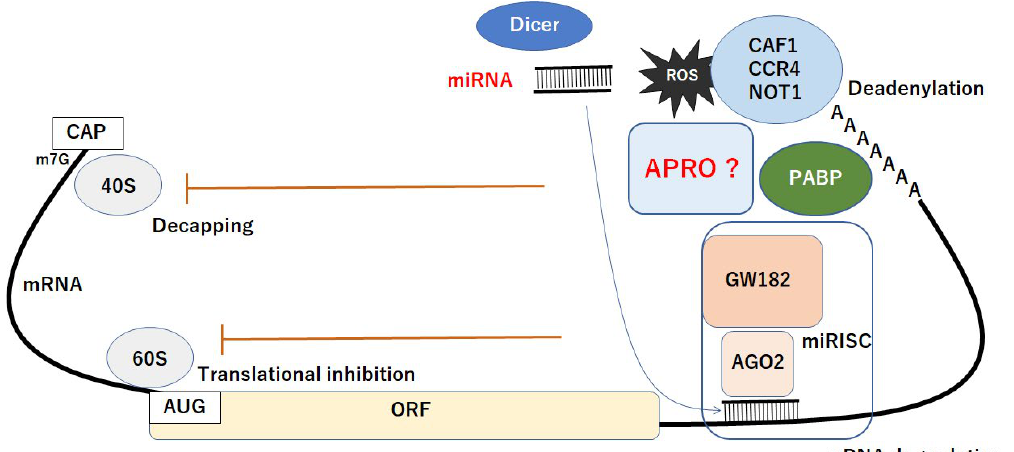
Figure 2. Schematic representation of miRNA-mediated functional inhibition of mRNA. The AGO2 protein interacts with GW182 constructing the miRISC complex, which may facilitate the deadenylation and mRNA degradation process by CAF1/CCR4/NOT1 with PABP and APRO complex. Consequently, the miRNA could play active roles in regulating posttranscriptional gene expression via the decapping, translational inhibition, deadenylation, and degradation of mRNA. The CAF1/CCR4/NOT1 complex is recruited to the 3′UTR of specific mRNAs through an interaction with PABP protein. APRO may also interact with PABP and recruits the CAF1/CCR4/NOT1 complex to initiate. Hammerhead represents inhibition. Note that some critical pathways have been omitted for clarity. CAF1: chromatin assembly factor-1; CAP: 5’ capping structure of mRNA; ORF: open reading frame; miRISC: microRNA-induced silencing complex; AUG: initiation codon (ATG); PABP: poly A binding protein; GW182: an 182 kDa protein with multiple glycine/tryptophan (GW) repeats; AGO2: Argonaute2; ?: the phenomena have not yet been confirmed at